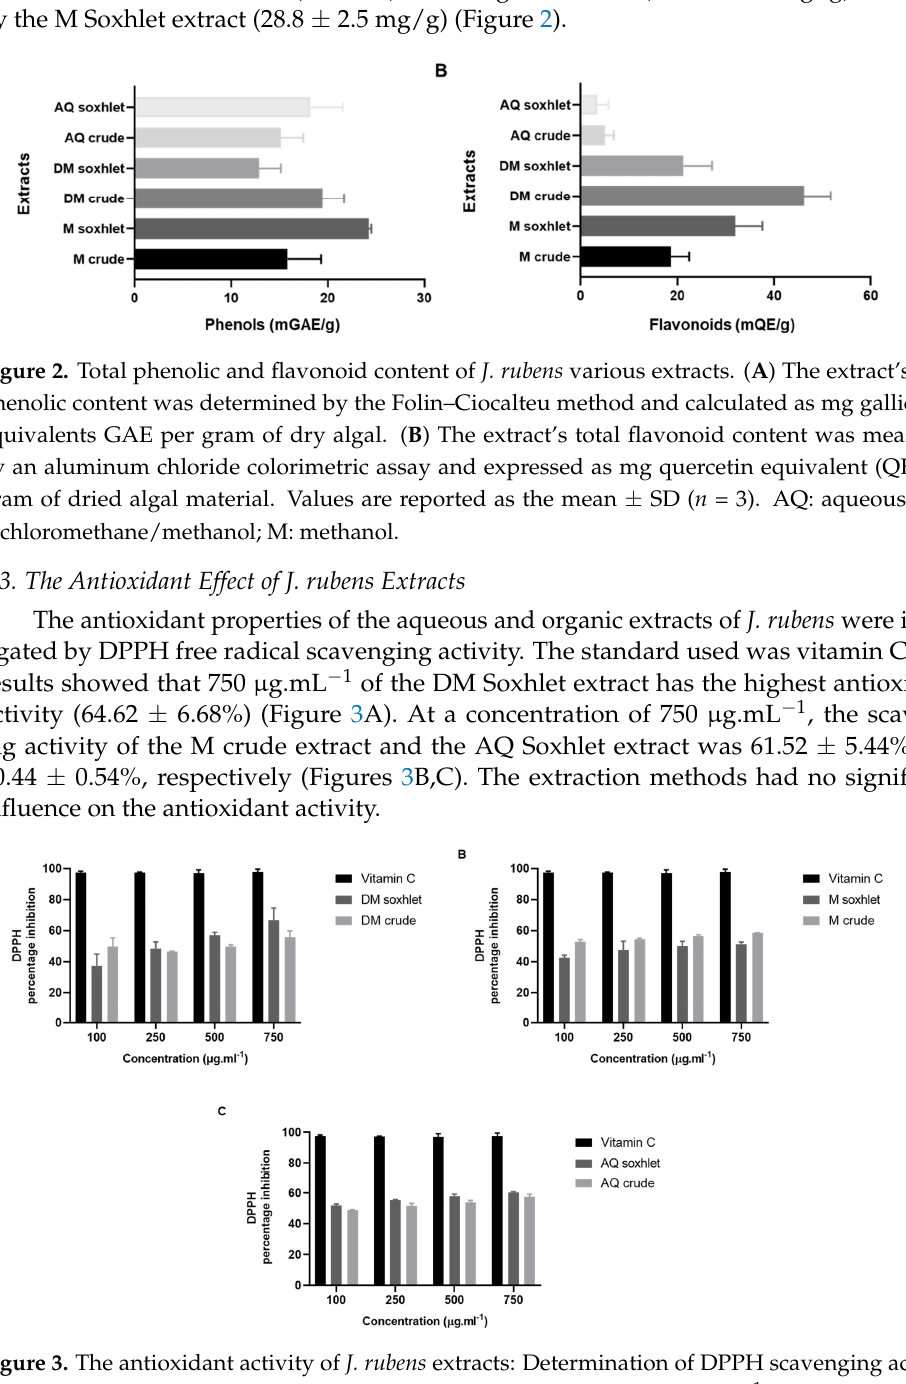
Table 4. Antibacterial effect of J. rubens extracts.